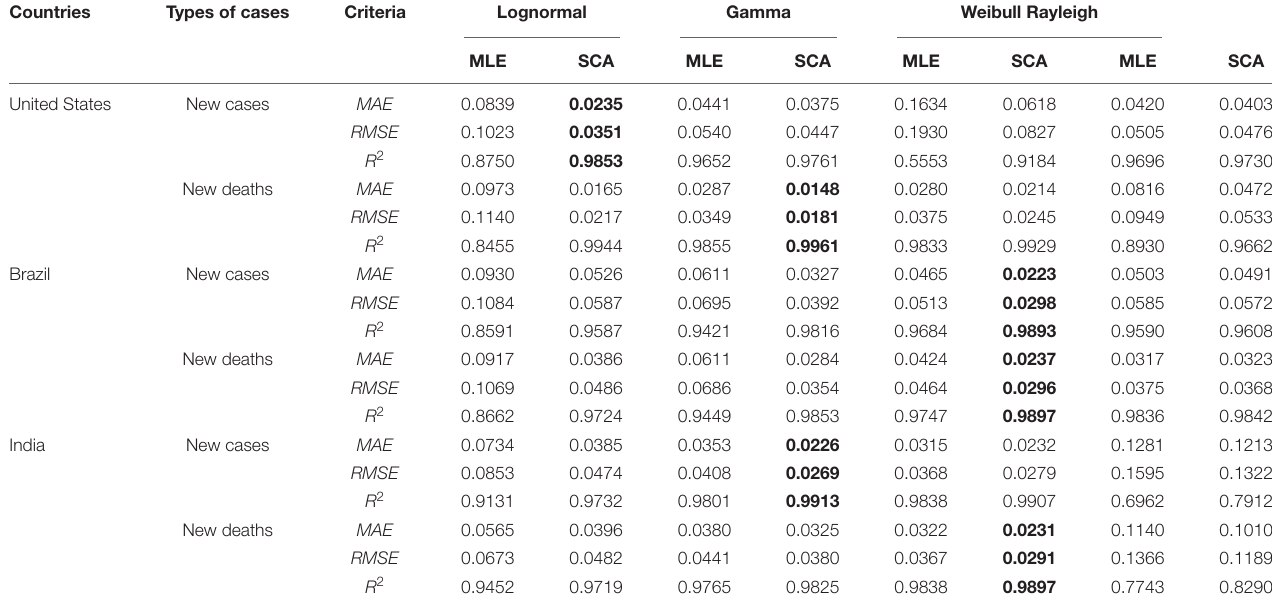
TABLE 4 | The criteria values of different distribution functions of six datasets.